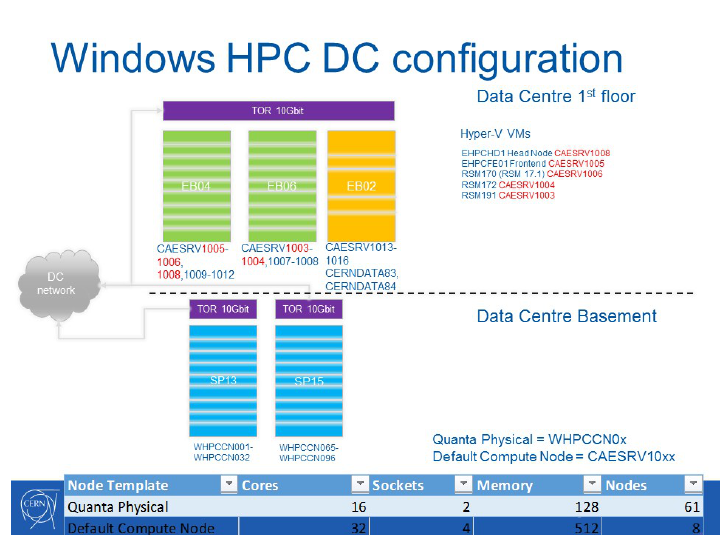
Figure 1. Windows HPC cluster at the CERN Data